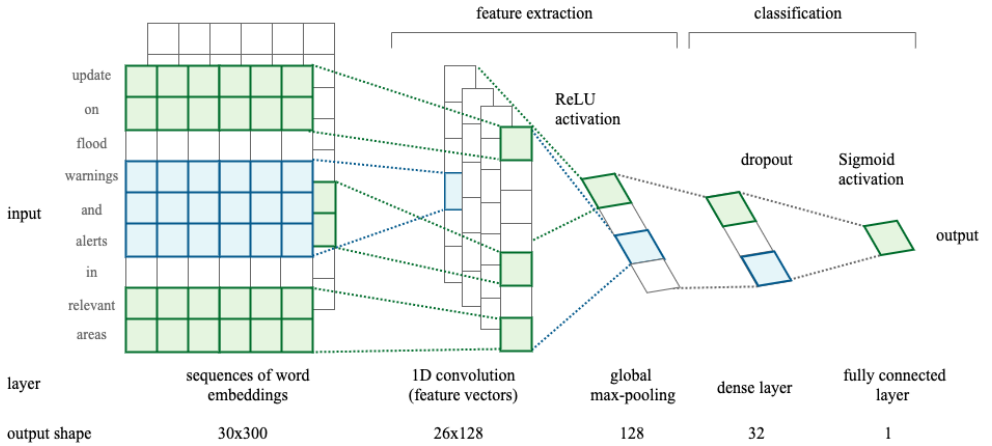
Figure 4. CNN architecture with an embedding layer, a convolutional layer using the ReLU function, a global max pooling layer, a dense layer, and an output layer using the sigmoid